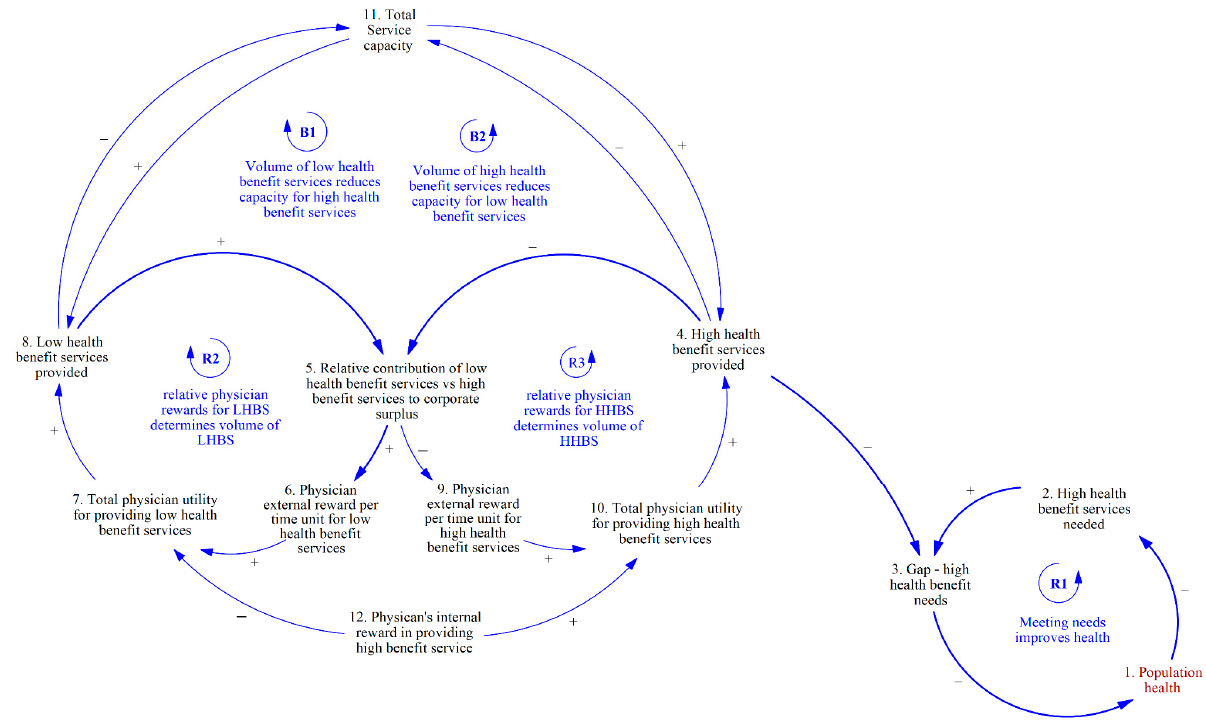
Figure 3. Levers influencing the mix between LHBS and HHBS are provided.